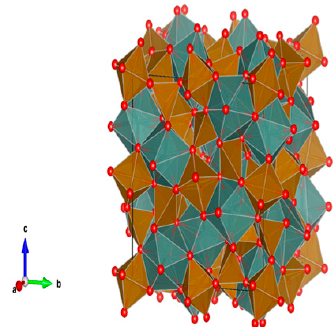
Figure 8. Garnet, Ca 3 Al 2 Si 3 O 12 . Structure cubic, Sp. gr. Ia3d. Cations can be Mg, Ca, Mn, Co, Cd, Al, Sc, Fe, Ga, Y, In, La, REE, Ti, Zr, Ru, Sn, N, P, V and As.